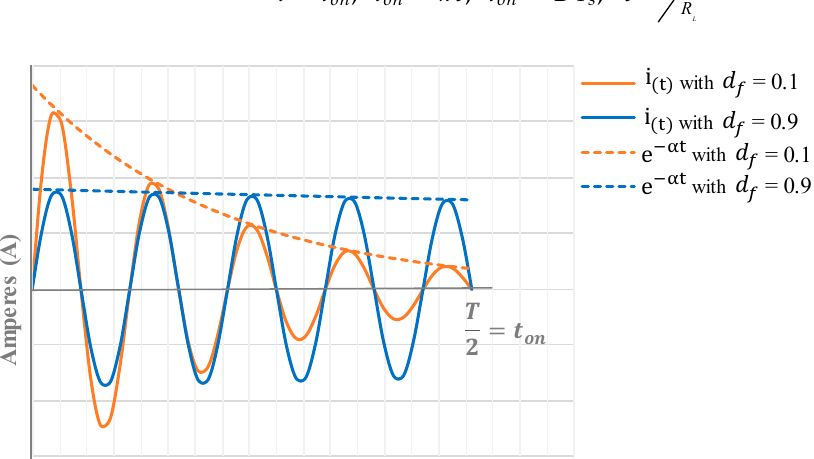
Figure 3. Influence of the damping factor “ d f “ in the instantaneous current waveform ( i (t ) ) in the resonant tank: current with less sinusoidal waveform (orange), current with sinusoidal waveform (blue).